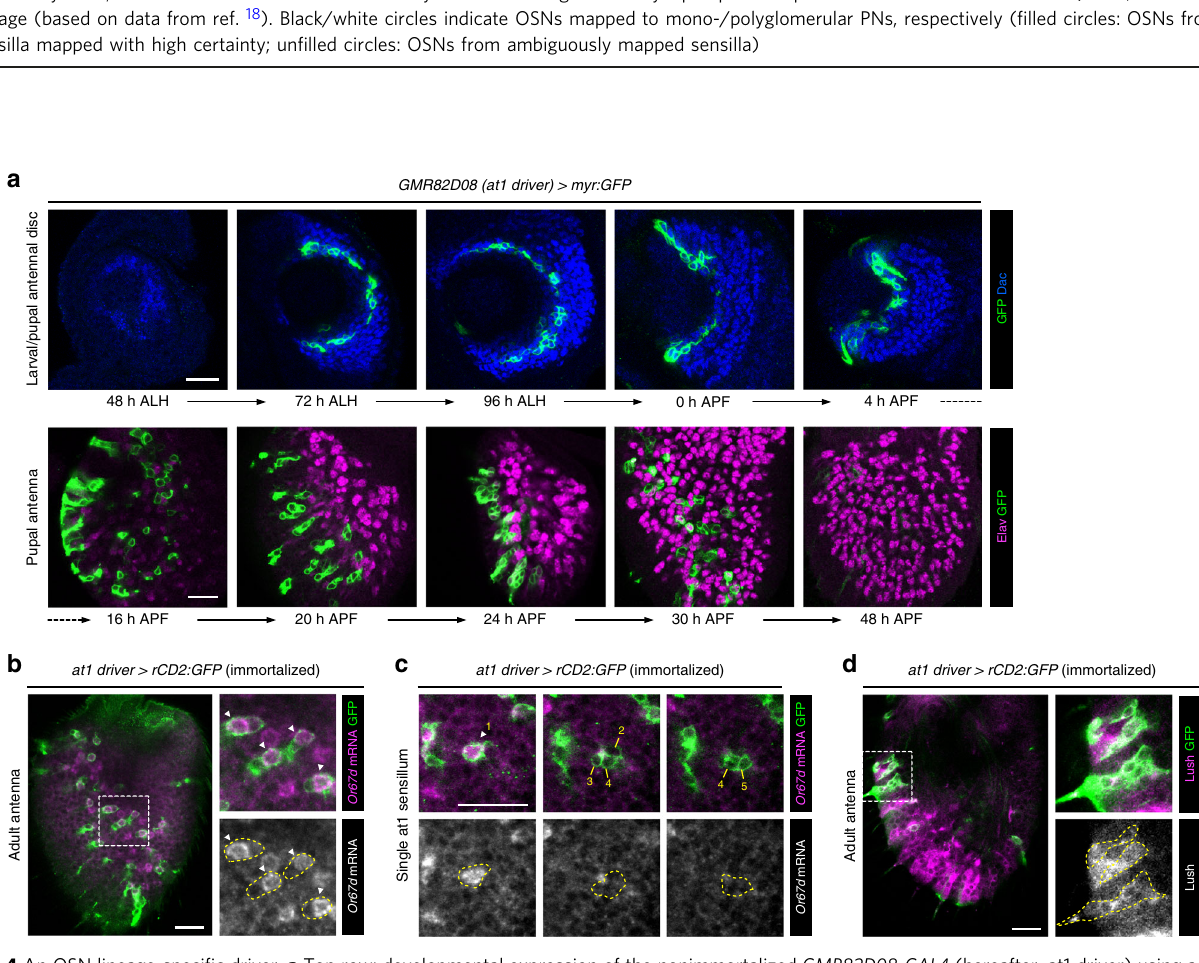
Fig. 4 An OSN lineage-speci fi c driver. a Top row: developmental expression of the nonimmortalized GMR82D08-GAL4 (hereafter, at1 driver) using a myr: GFP reporter (green) in the antennal disc SOPs (region marked by α -Dac (blue)) during late larval/early pupal stages. Bottom row: the at1 driver is expressed in the daughter cells of these SOPs in the developing pupal antenna but progressively loses its expression from 20 h APF as OSNs differentiate (visualized with the neuronal marker α -Elav (magenta)). Scale bar = 20 µ m in this and other panels. b Immortalization of the at1 driver reveals labeling of clusters of cells in the adult antenna by an rCD2:GFP reporter (green). RNA fl uorescence in situ hybridization demonstrates that a single cell within each cluster (arrowheads in the inset images) expresses Or67d mRNA (magenta). c Representative example of a single sensillum in the adult antenna labeled by the immortalized at1 driver, viewed at three focal planes. There is a single Or67d mRNA-positive OSN (cell 1, arrowhead), fl anked by four non-neuronal support cells (cells 2 – 5). d Sensilla cells labeled by the immortalized at1 driver lineage ( α -GFP; green) also express Lush (magenta), an odorant binding protein unique to trichoid sensilla support cells 72